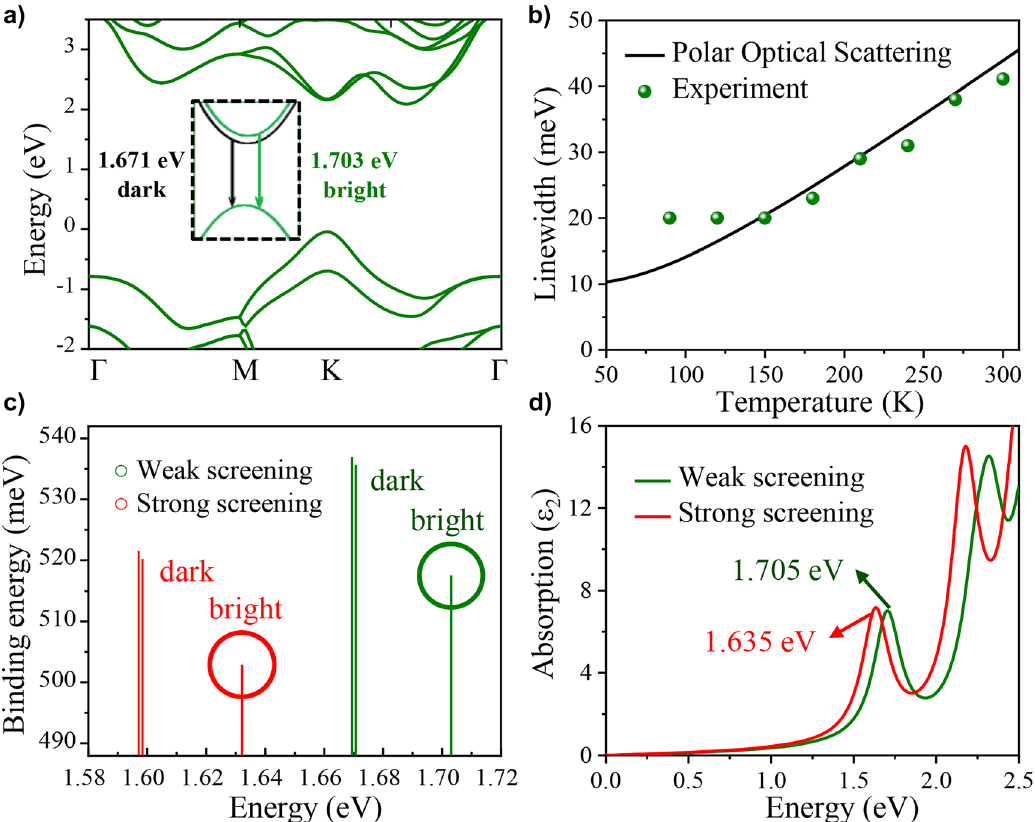
Figure 5: Theoretical calculation of WSe 2 on SOI or nano fi ngers. (a)ElectronicstructuresofmonolayerWSe 2 onSOI,Inset:enlargedviewofelectrontransitionfromthebottomofconductionbandtothetopof valence band. (b) PL linewidth as a function of temperature. (c) Dark and bright excitons and their corresponding binding energy under weak and strong screening. (d) Imaginary part of dielectric function under weak and strong